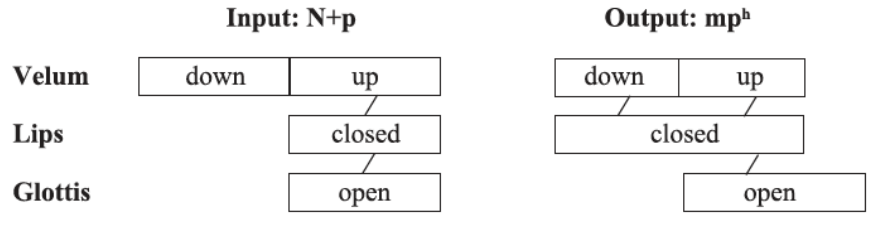
Figure 1: Gestural misalignment leads to aspiration (based on Halpert